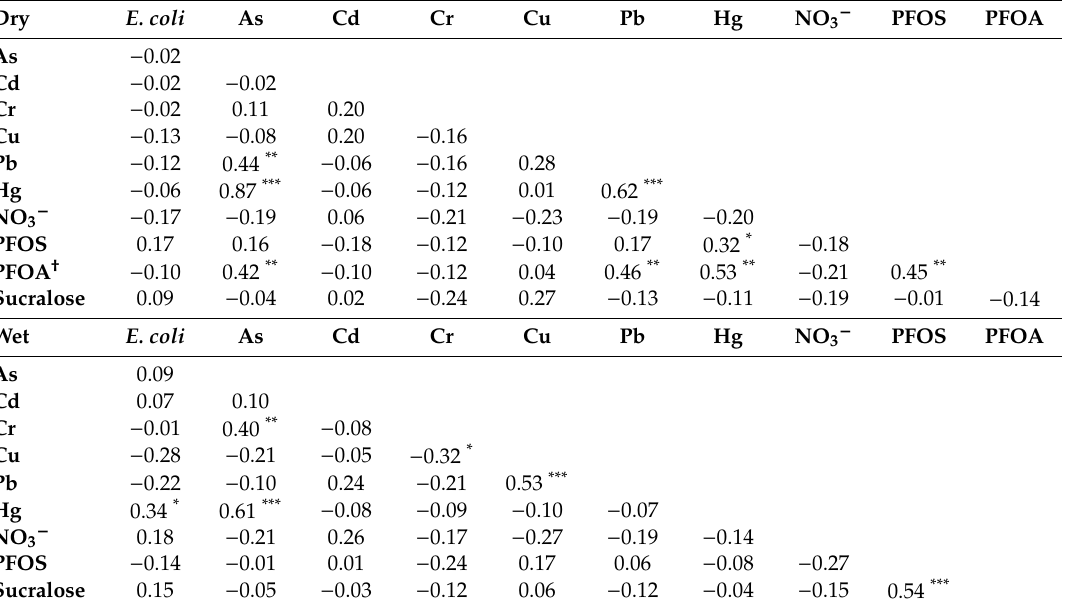
Table 4. Summary of Spearman pairwise rank correlations by